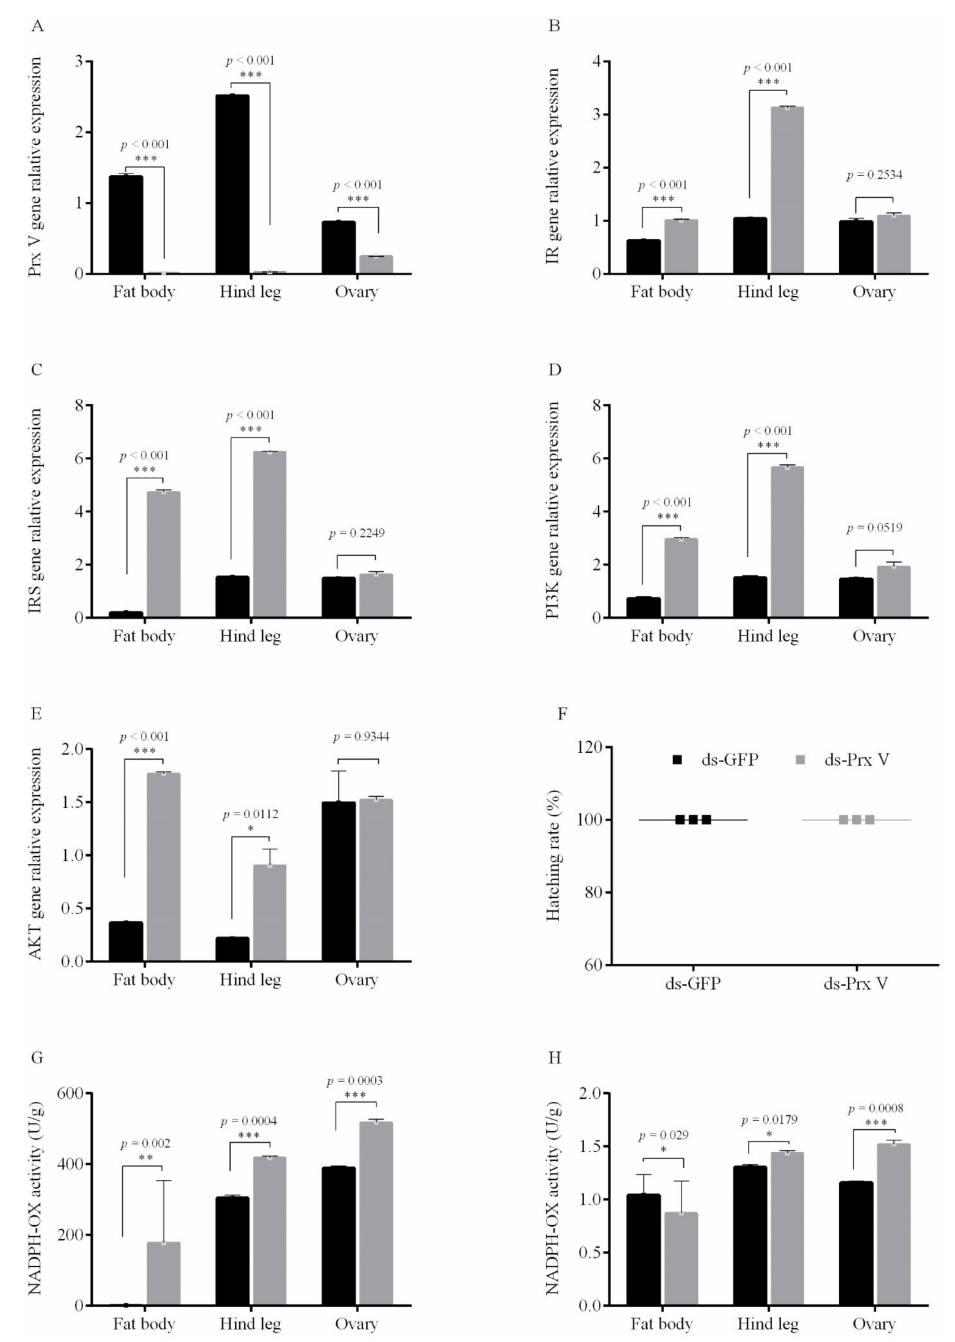
Figure A5. Gene relative expression, reactive oxygen species (ROS), and NADPH redox (NADPH- OX) changes in fat bodies, ovaries, and hind legs and egg hatching incidence after injection of adults with the RNAi Prx V gene compared to GFP (control) under long photoperiod conditions (L16:D8). ( A ) Prx V gene ( B ) IR gene, ( C ) IRS gene, ( D ) PI3K gene, ( E ) AKT gene relative expression, ( F ) egg hatching incidence, ( G )ROS activity, ( H ) NADPH-OX activity after injection of adults with the RNAi Prx V gene compared to GFP (control). Data are the mean ± SEM from three independent replicates, the gray bar indicates RNAi treatments, while the black bar indicates. GFP controls (* p < 0.05, ** p < 0.01, and *** p < 0.001 vs. GFP controls, Student’s t